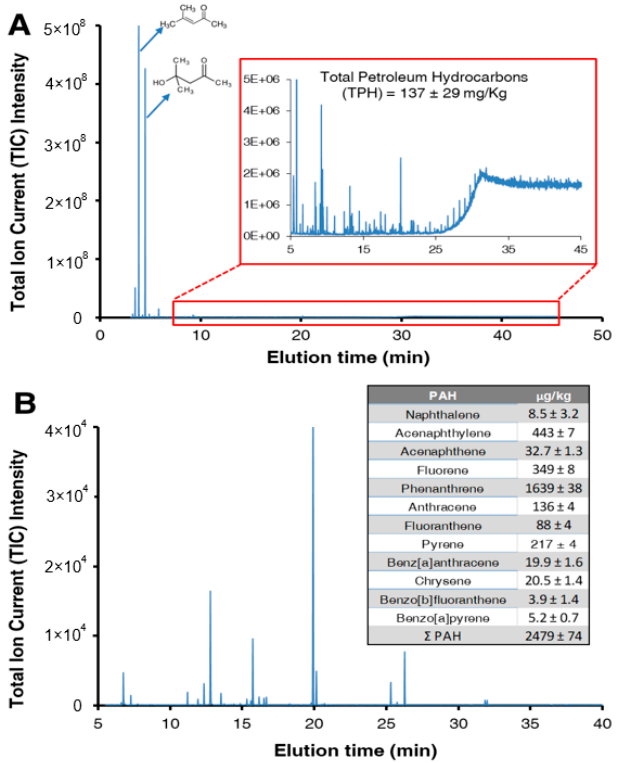
Figure 2. ( A ) Total Ion Current GC-MS chromatogram for the quantification of TPH in the contam- inated soil. ( B ) Single Ion Monitoring GC-MS chromatogram for the quantification of polycyclic aromatic hydrocarbons (PAH) in the contaminated